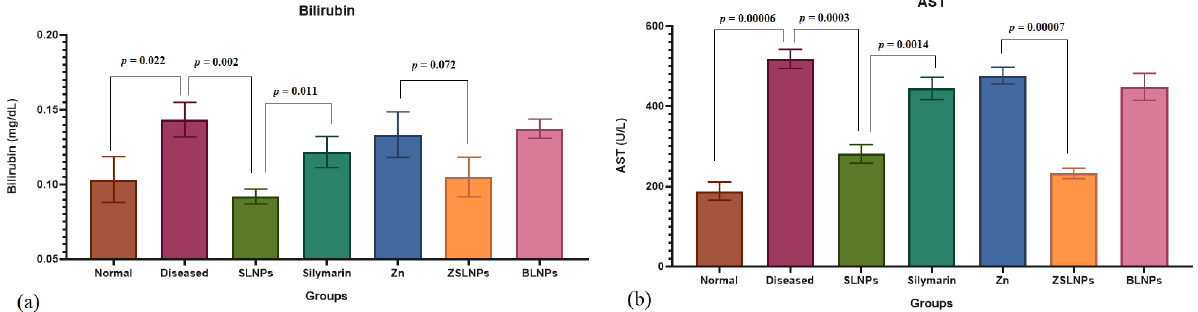
Figure 9. Mean liver function test results of rats ( n = 5) ( a ) bilirubin and ( b ) AST, and statistical significance between groups using independent t -test, after sacrifice following the different treatments for a period of 21 days through gavage: diseased, SLNPs (500 µ g/kg BW), silymarin (10 mg/kg BW), Zn (10 mg/kg BW), ZSLNPs (10 mg/kg BW + 500 µ g/kg BW), and BLNPs (500 µ g/kg BW).